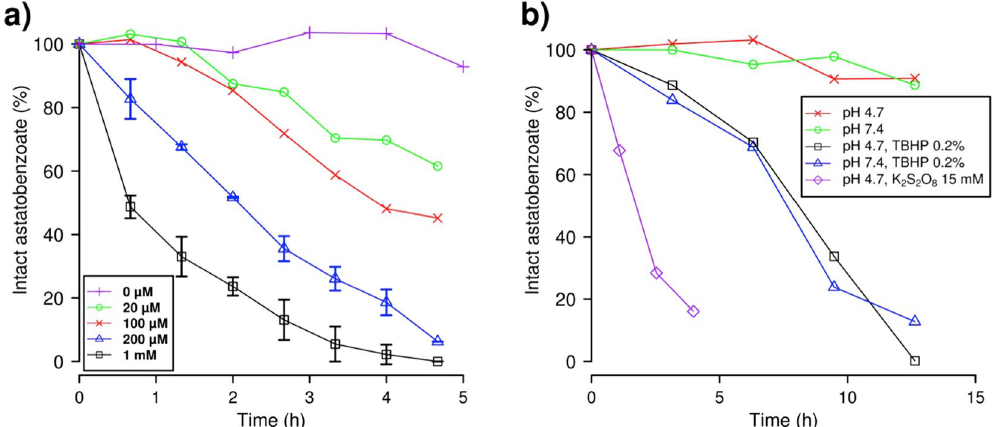
Figure 1. Influence of oxidants on the deastatination of ethyl 3-astatobenzoates. The proportion of intact ethyl 3-astatobenzoate is assessed by reverse-phase HPLC coupled to a dual-flow cell gamma detection system 42 . ( a ) Concentration-dependent deastatination promoted by permanganate. The NaMnO 4 concentration is varied between 0 and 1 mM while the pH value is fixed at 4.7 with a phosphate-acetate buffer (50 mM). ( b ) Effect of peroxodisulfate (purple) and tert -butyl hydroperoxide (TBHP, black and blue) on the ethyl 3-astatobenzoate stability (see text).